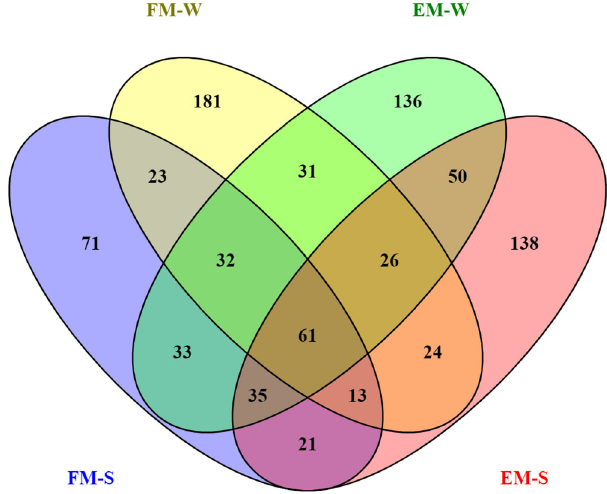
Fig. 3 Distribution of uniquely expressed genes in the metacarpal adipose tissue (M). Shared and uniquely expressed genes in Finnish (FM- W, FM-S) and Even (EM-W, EM-S) reindeer in the spring (-S) and winter (-W) are shown in the Venn diagram. Table 1 The number of signi fi cantly identi fi ed differentially expressed genes (DEGs) in Finnish (F) and Even (E) reindeer due to seasonal changes (S, spring; W, winter) in the metacarpal (M), perirenal (P), and prescapular (S) adipose tissues.